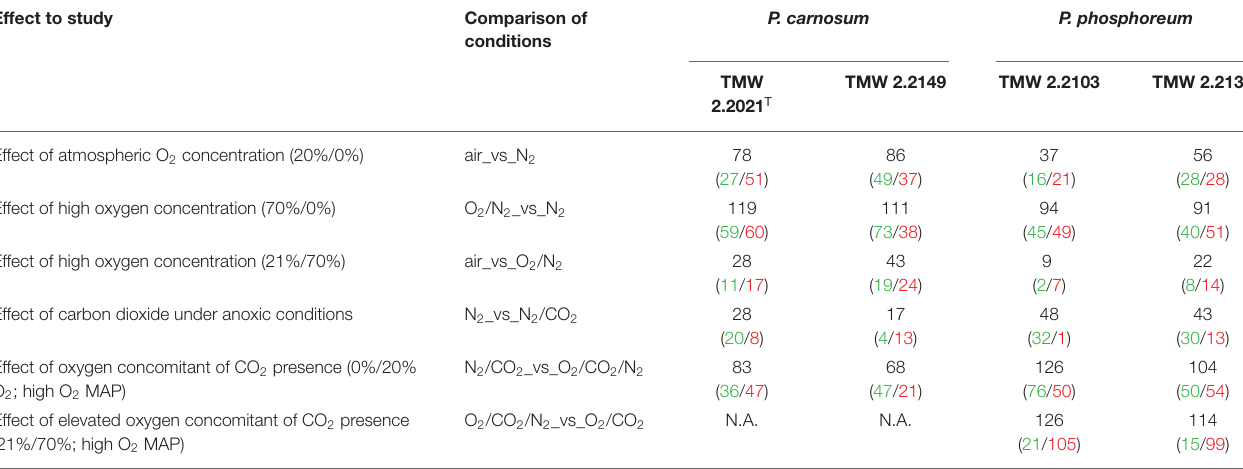
TABLE 1 | Effects studied and direct comparisons between conditions performed to study them. Effect to